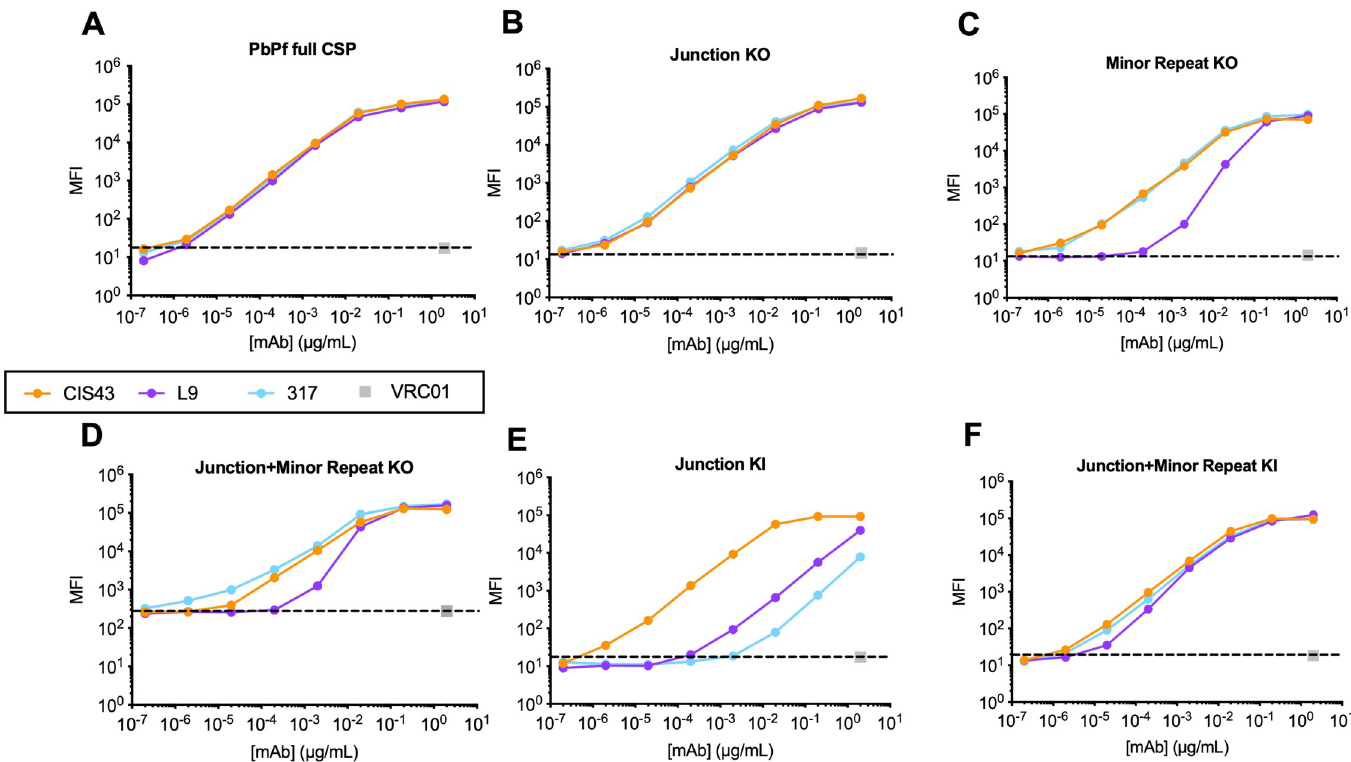
Fig 2. Flow cytometry analysis of PfCSP mAbs binding to transgenic SPZ lines. Flow cytometric measurement of various concentrations (2.0–2 x 10 − 7 μ g/mL) of mAbs CIS43, L9, and 317 binding to freshly isolated SPZ expressing (A) PbPf full CSP, (B) Junction KO, (C) Minor Repeat KO, (D) Junction and Minor Repeat KO, (E) Junction KI, and (F) Junction and Minor Repeat KI. The anti-HIV-1 mAb, VRC01 was included as an isotype control. mAb binding is expressed as median fluorescence intensity (MFI).